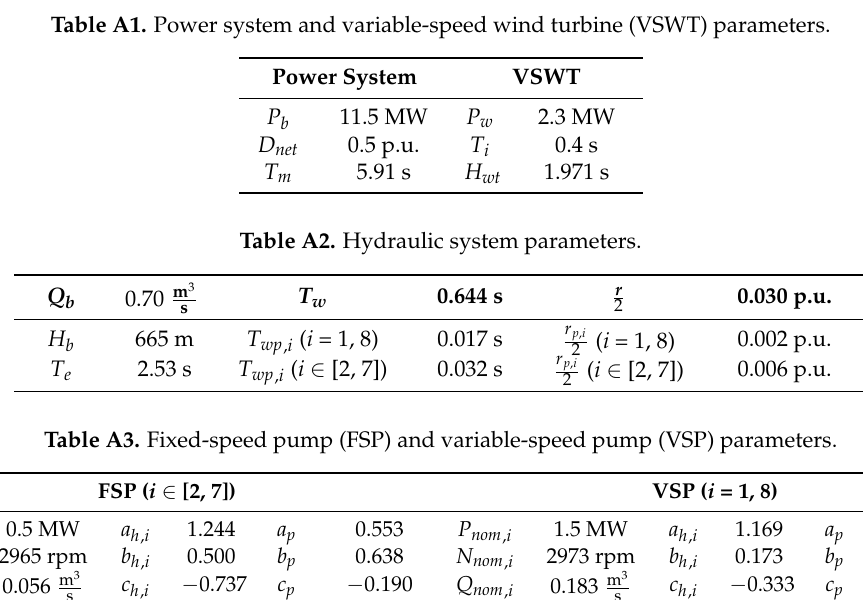
Table A4. VSP controller